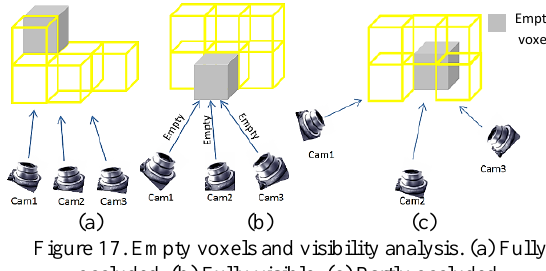
Figure 17. Empty voxels and visibility analysis. (a) Fully occluded. (b) Fully visible. (c) Partly occluded.